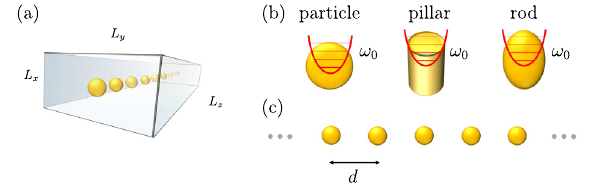
Figure 1: Panel (a): a sketch of our system: a chain of dipoles embedded inside a cuboid cavity waveguide of dimensions L x × L y × L z .Panel(b):Eachdipoleismodeledasaharmonicoscillator ofresonancefrequency ω 0 .ItcanberealizedbytheMieresonancein a dielectric nanoparticle, spin waves in a magnetic micropillar, or localizedsurfaceplasmonsina metallicnanorod.Panel(c):thelong chainof N ≫ 1oscillatingdipoles,regularlyspacedbythecenter-to- center separation d